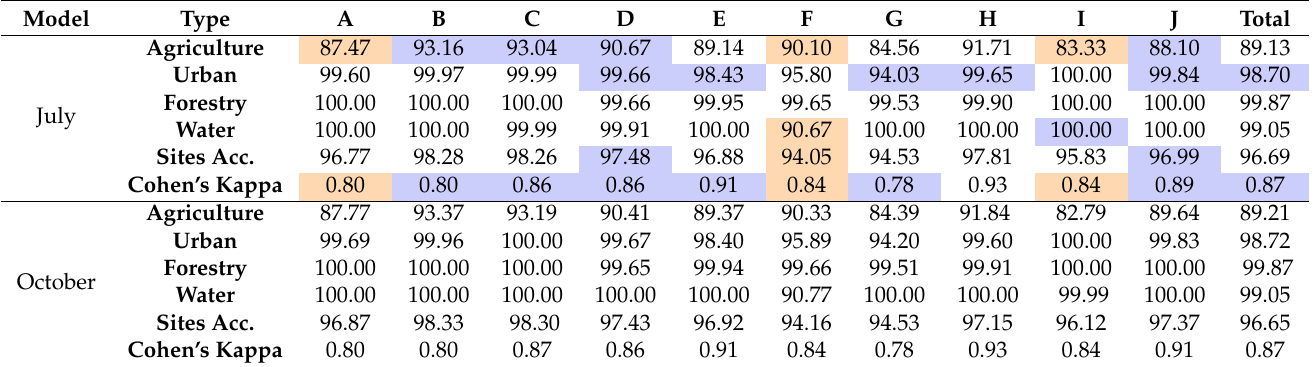
Table 4. Total accuracy and kappa coefficient of the model when run in (i) July and (ii) October. Highlighted with light blue are the plots for which the optimized model of this study performs better (>0.5%) than the Data-Augmented Learning Material Fully Connected Recurrent Neural Network (DALM-FCRNN) in [21]. Highlighted with light orange are the plots with inferior performance